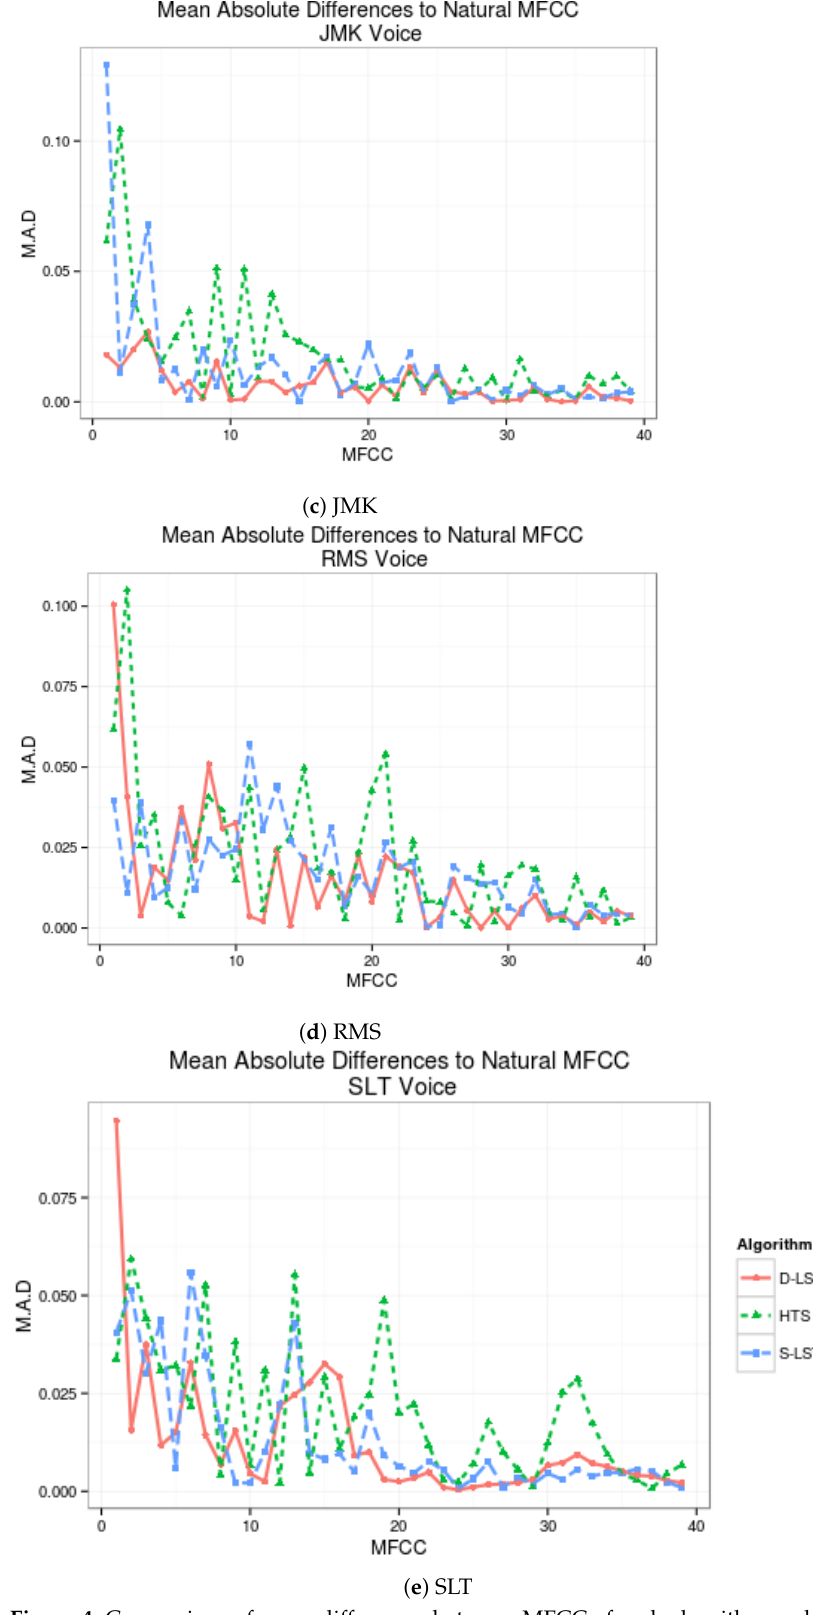
Figure 4. Comparison of mean differences between MFCC of each algorithm and natural voice. Discriminative-LSTMA-1 provides better approximation to natural MFCC than regular LSTMA-1 in 20 of 39 coefficients from SLT voice (51.28%), as seen in Figure 4.